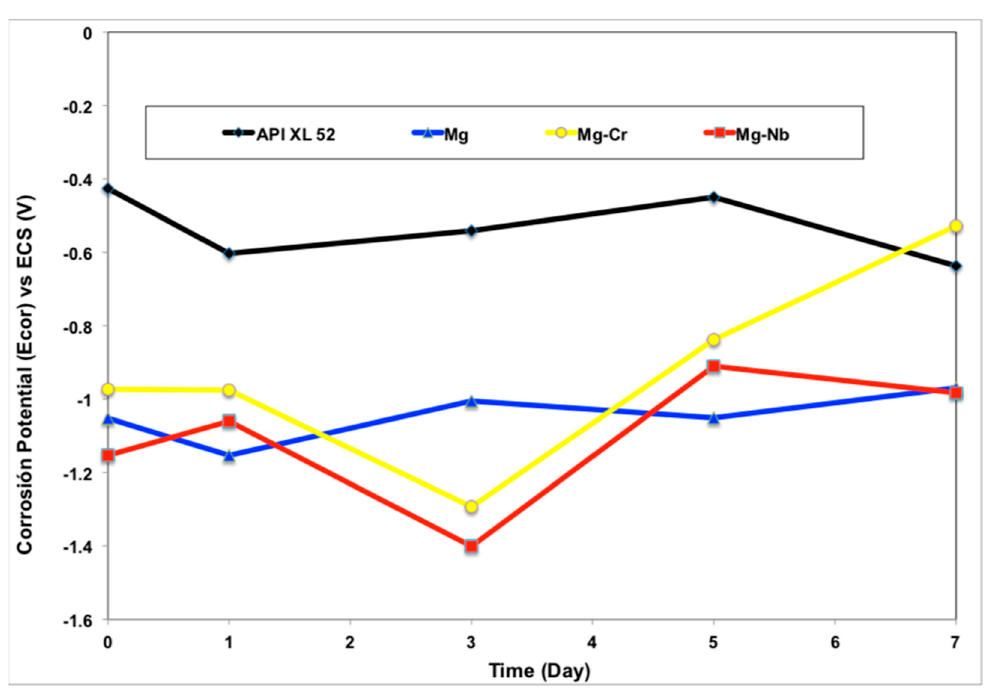
Figure 5. Corrosion potential (E corr ) for X52 steel, pure-Mg, Mg-1Cr, and Mg-1Nb.